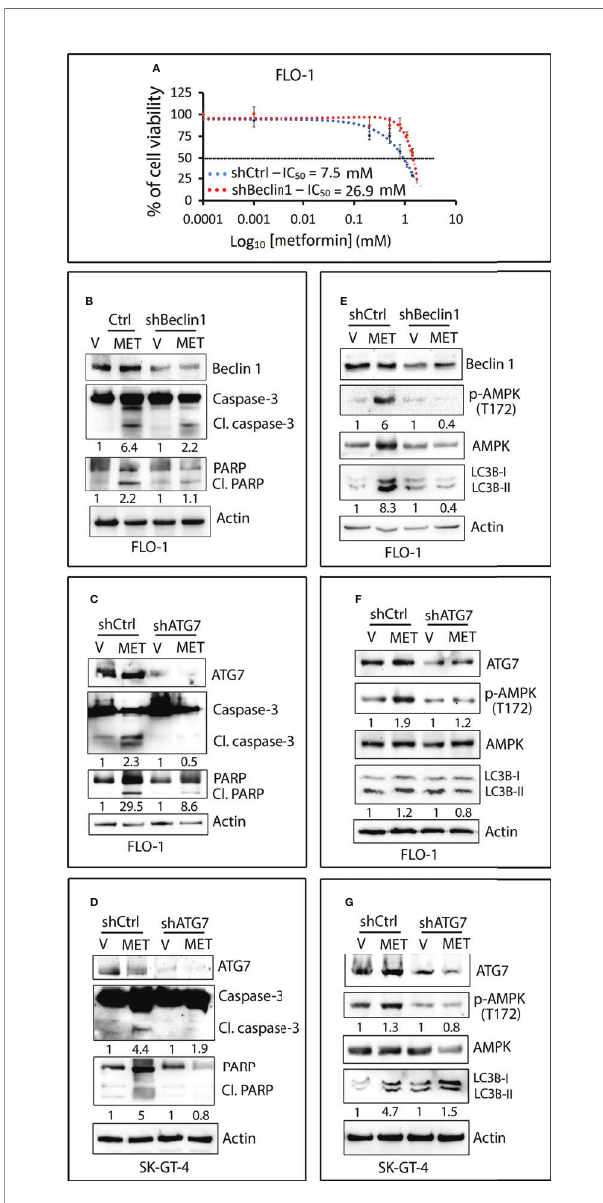
FIGURE 7 | Metformin-induced apoptosis requires autophagy in EAC cells. (A) FLO-1 cells stably expressing control shRNA (shCtrl) or Beclin 1 shRNA (shBeclin1) were treated with increasing concentrations of metformin for 72 h and then subjected to CCK-8 cell viability assay. (B) Western blot analysis of Beclin 1, caspase-3, and PARP proteins in FLO-1-shCtrl and FLO-1-shBeclin1 cells treated with vehicle or 10 mM metformin for 72 h. (C) Immunoblotting of ATG7, Caspase-3, and PARP proteins in FLO-1-shCtrl and FLO-1-shATG7 cells treated with vehicle or 10 mM metformin for 72 h. (D) Western blot analysis of ATG7, caspase-3, and PARP proteins in SK-GT-4-shCtrl and SK- GT-4-shATG7 cells treated with 15 mM metformin for 96 h. (E) Western blot analysis of Beclin 1, p-AMPK (T172), AMPK, and LC3B proteins in FLO-1-shCtrl and FLO-1-shBeclin1 cells treated with vehicle or 10 mM metformin for 2 h. (F) Western blot analysis of ATG7, p-AMPK (T172), AMPK, and LC3B proteins in FLO-1-shCtrl and FLO-1-shATG7 cells treated with vehicle or 10 mM metformin for 2 h. (G) Immunoblotting of ATG7, p-AMPK (T172), AMPK, and LC3B proteins in SK-GT-4-shCtrl and SK-GT-4-shATG7 cells treated with 15 mM metformin for 2 h. Gel loading was normalized for equal b